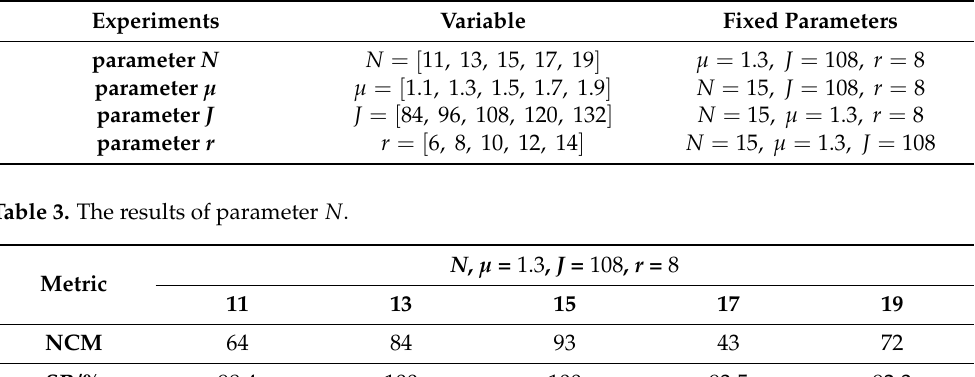
Table 2. The detail of parameter settings.